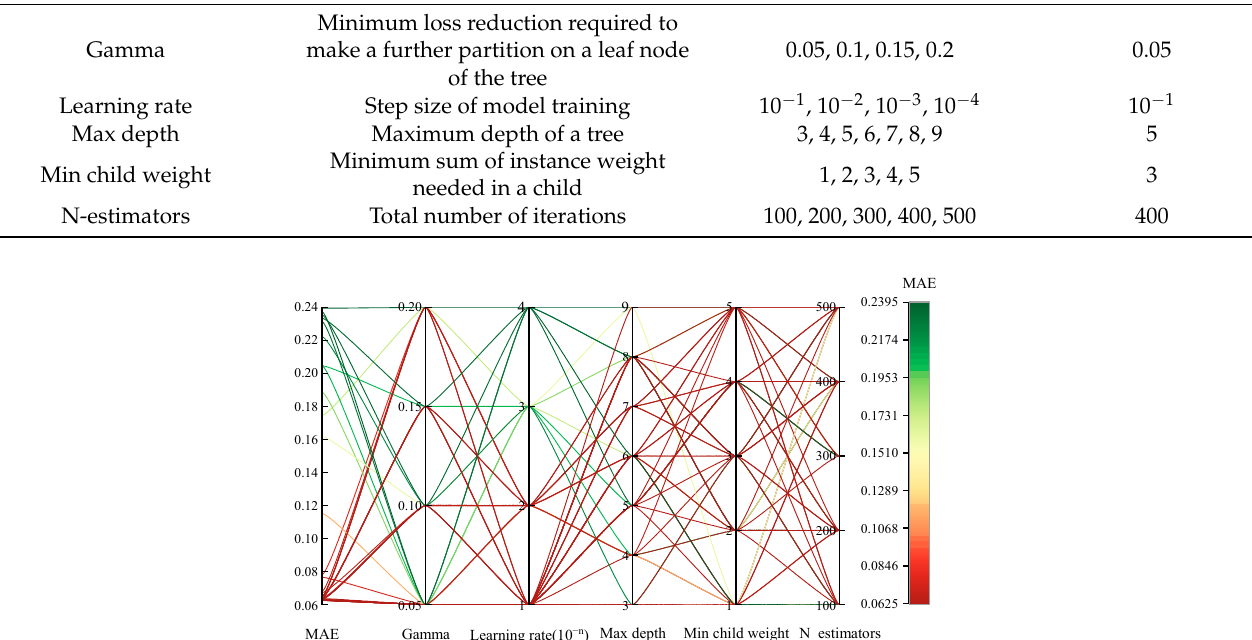
Figure 9. Process for optimizing SVM hyperparameters. Table 5. Optimized hyperparameter types, meanings, ranges and optimal values of XGBoost.